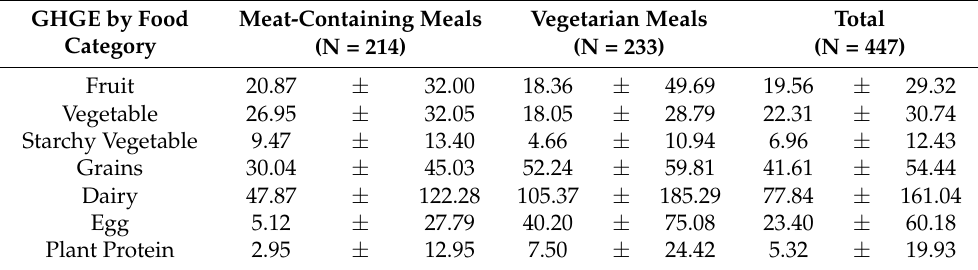
Table A2. Descriptive statistics for GHGE (g CO 2 eq/plate) by meal type and food category, presented as M ±